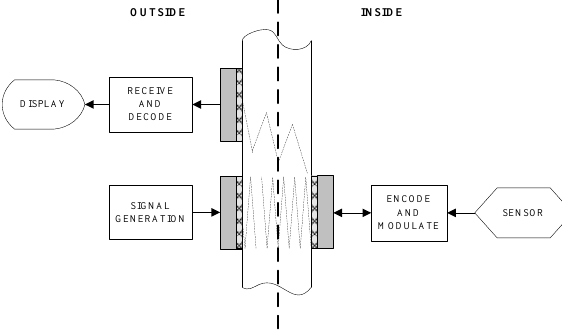
Figure 8. Diagram of three-transducer configuration, redrawn from Murphy [55].